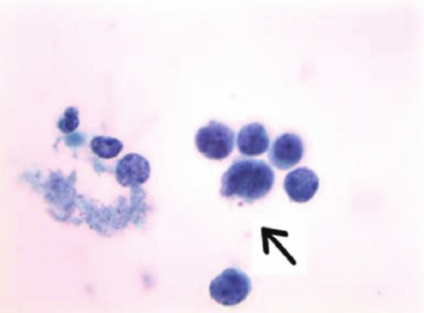
Figure 4: Microscopic image of a highly cellular cell block showing large aggregates of malignant cells. The cells are morphologically similar to those seen in the liquid based cytology with high nuclear/cytoplasmic ratios and finely granular chromatin. No cyto- plasmic orangeophilia or evidence of keratinization is discerned. Admixed apoptotic bodies, necrotic granular debris, and inflamma- torycellsarepresent(hematoxylinandeosinstain,CellBlock,630x).